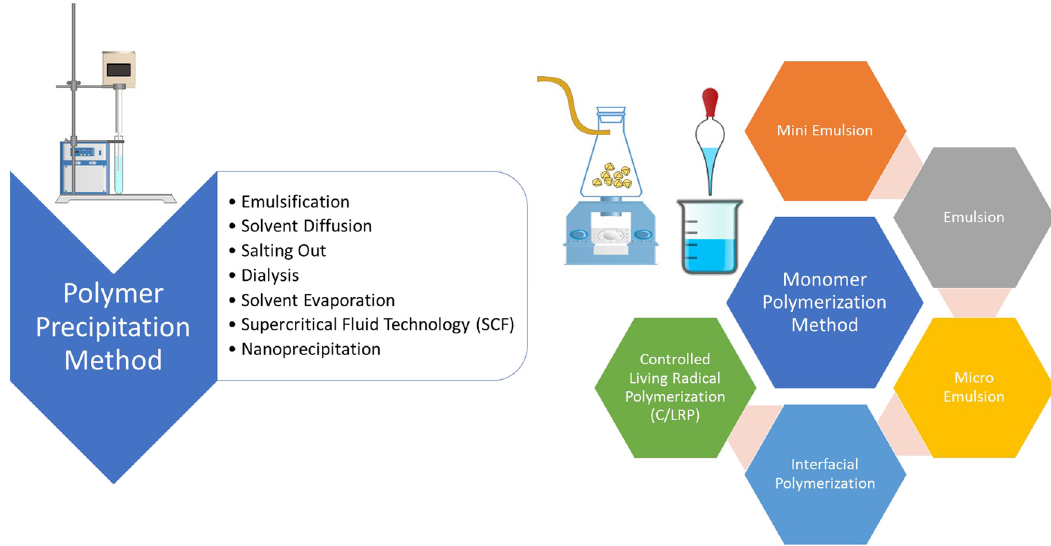
Figure 4: General methods of preparations and properties of